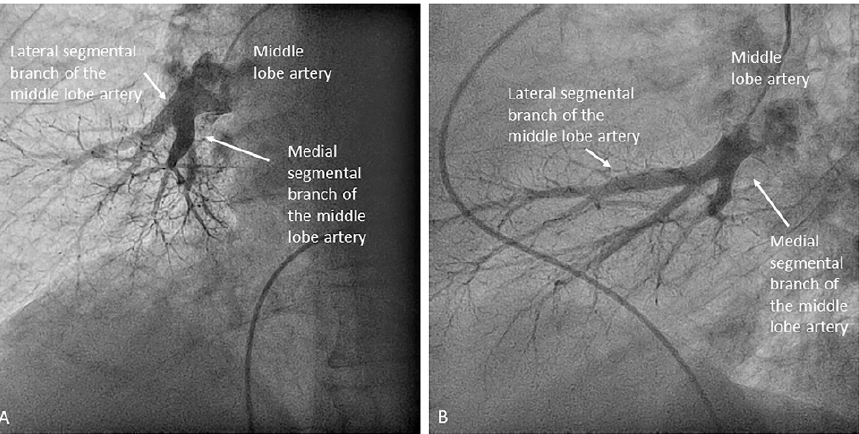
Figure 12. Middle lobe artery and segmental branches: medial (A5) and lateral (A4): ( A ) anteroposterior view and ( B ) lateral view.